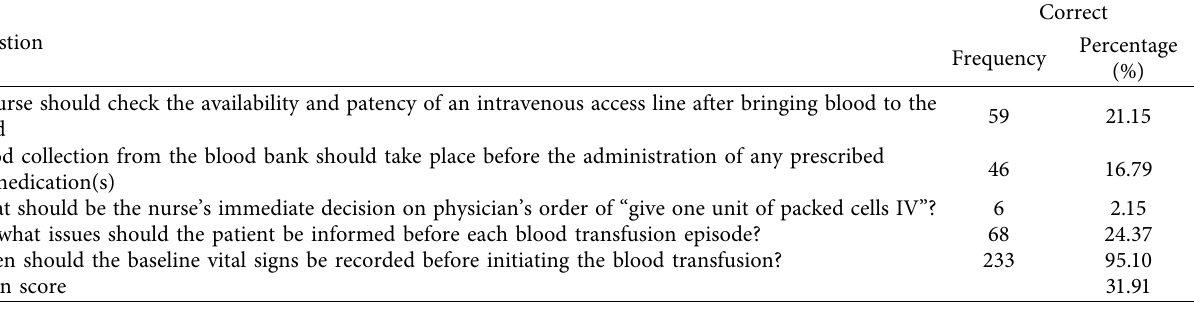
Table 3: Nurses’ knowledge on patient preparation before blood transfusion.